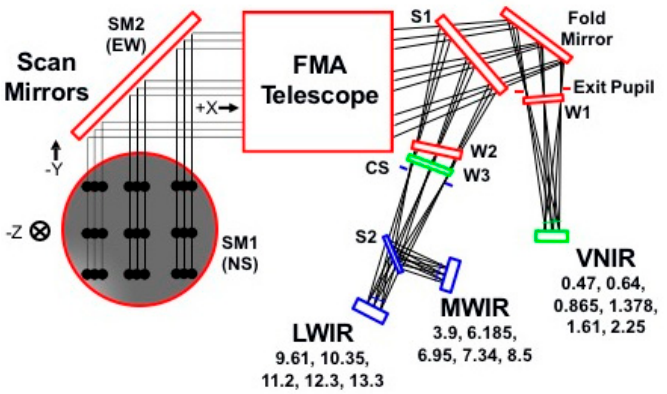
Figure 2. ABI optical components. (SM = Scan Mirror; EW = East–West; NS = North–South; FMA = Four Mirror Anastigmat; S1, S2 = Beamsplitter 1 and 2; CS = Cold Stop; W1, W2, W3 = Windows 1, 2, and 3; LWIR = Longwave Infrared; VNIR = Visible and Near IR; MW IR = Mid-Wave IR).